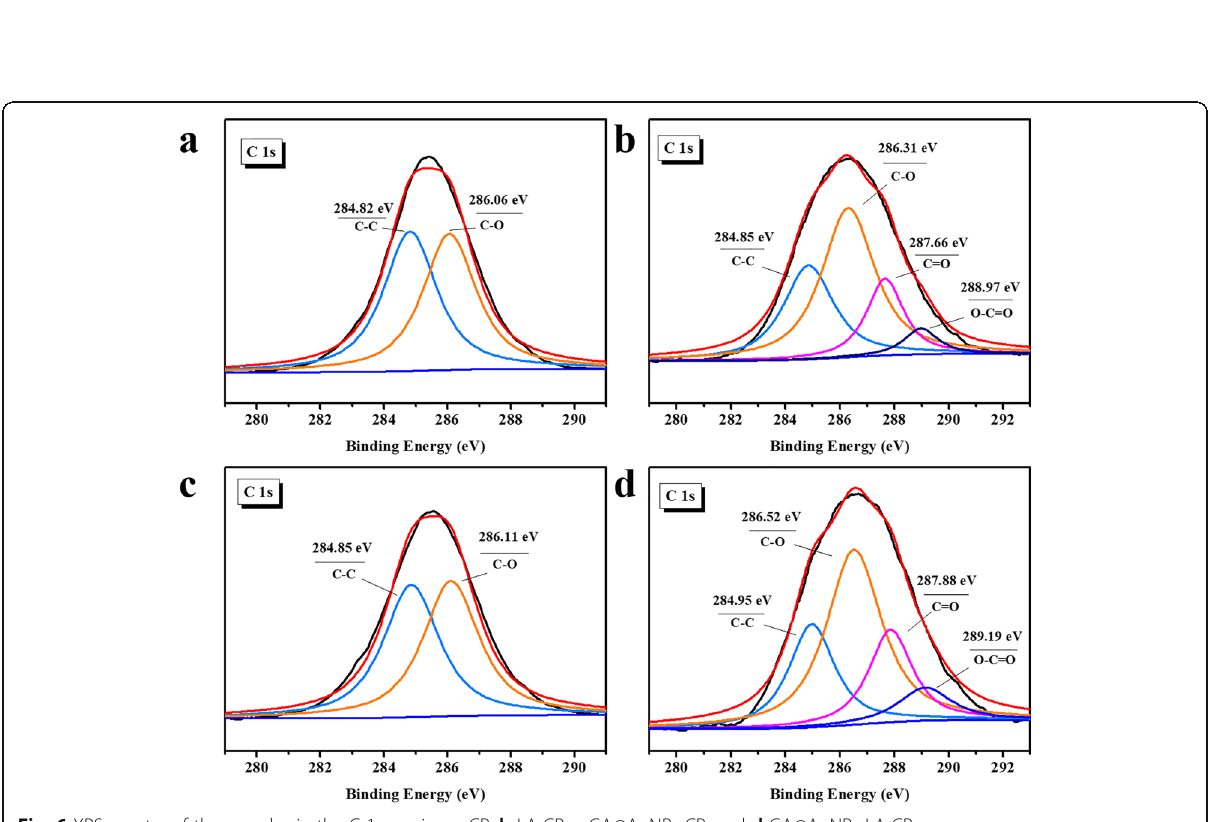
Fig. 6 XPS spectra of the samples in the C 1 s region a CP, b LA-CP, c GA@AgNPs-CP, and d